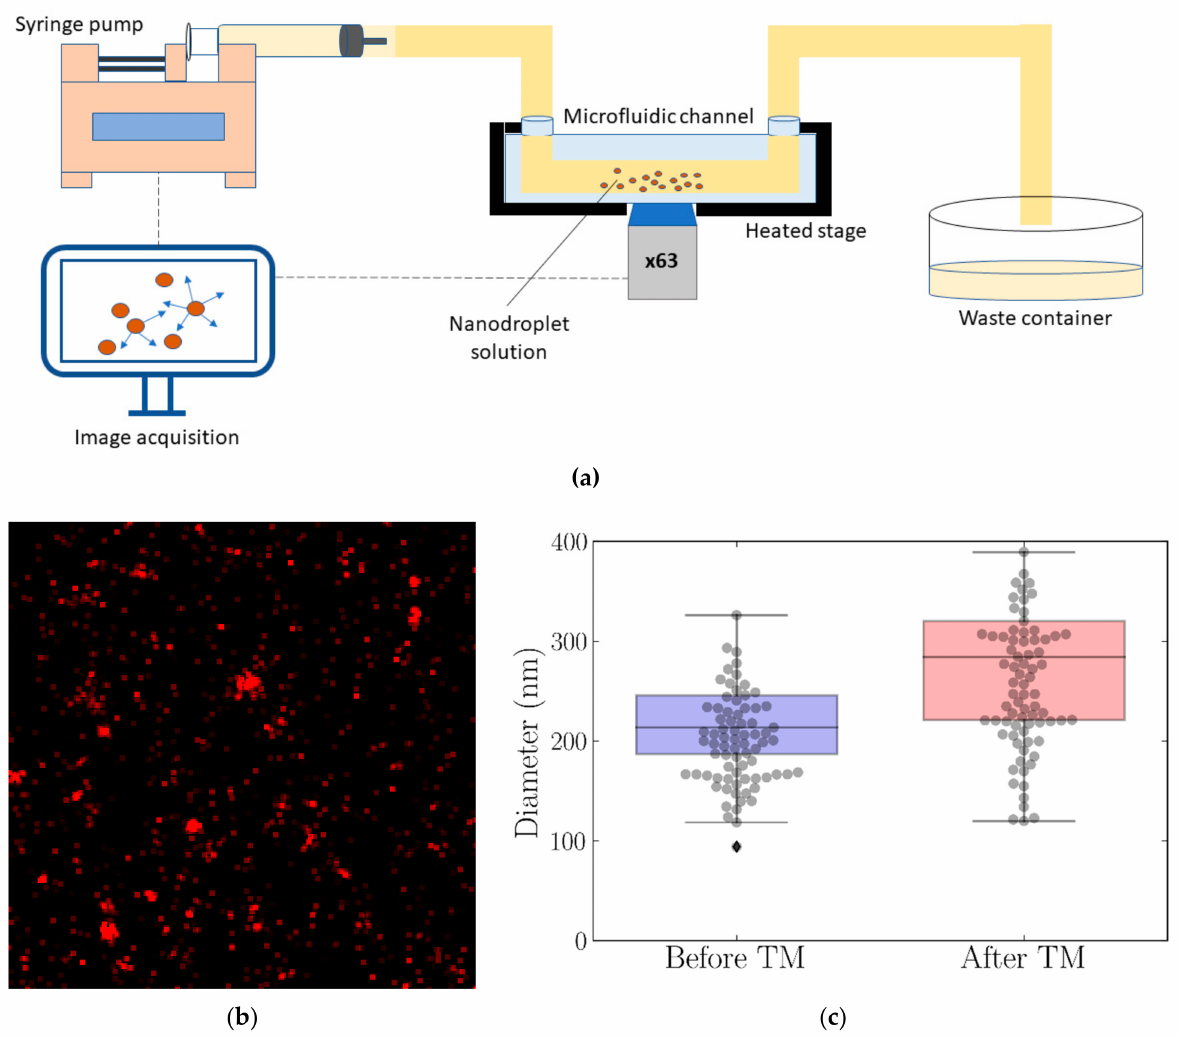
Figure 3. Size distribution of the nanodroplets obtained by confocal imaging in combination with the iPED method. ( a ) A schematic of the experimental setup used to acquire confocal microscope images of the BSA-TDFH nanodroplets in the microfluidic channel. ( b ) A representative confocal image used for iPED analysis. ( c ) Nanodroplet size distribution before and after thermal